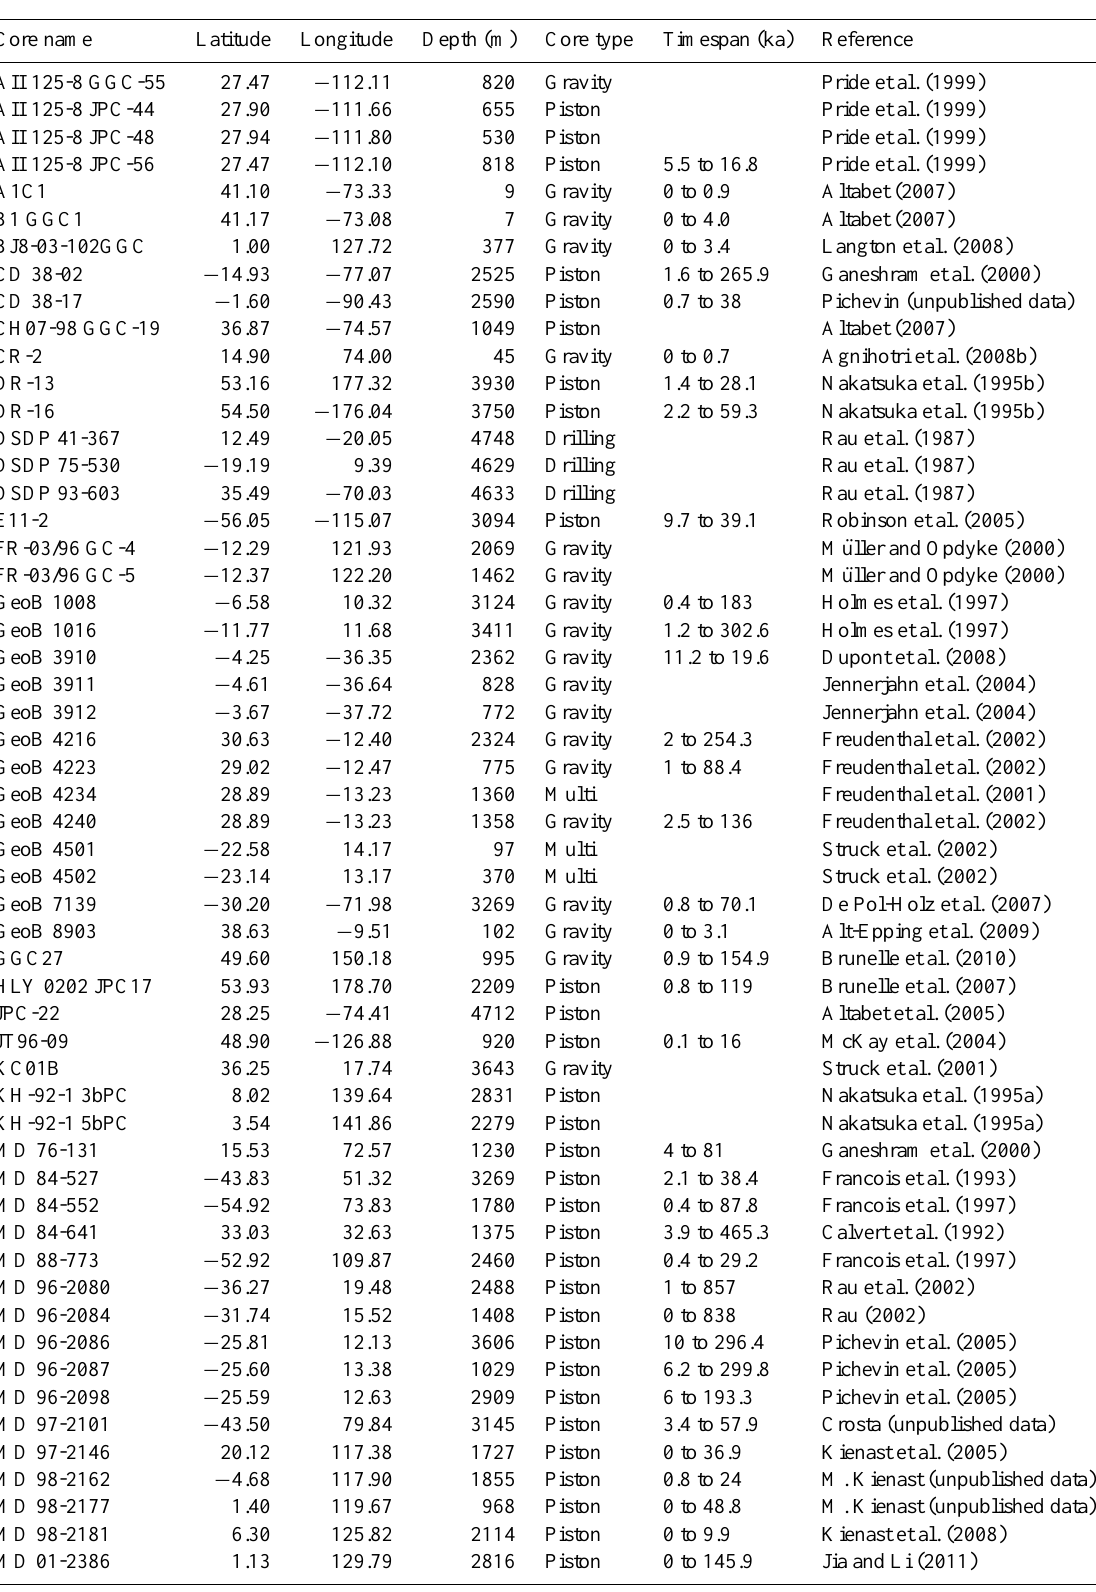
Table 1. List of δ 15 N records in the NICOPP database (as of 21 September